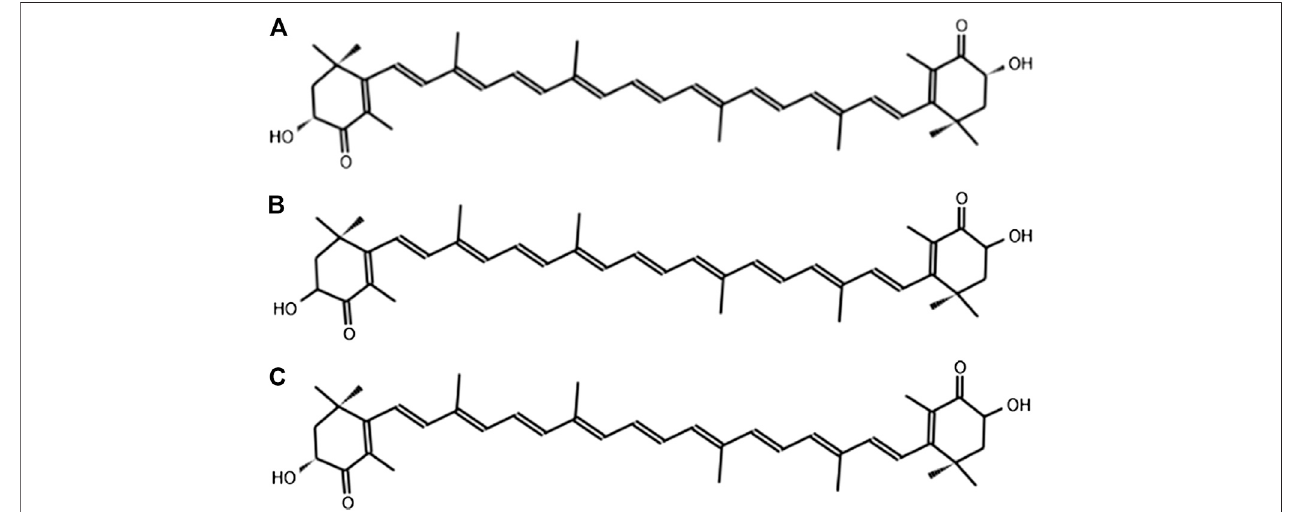
FIGURE 1 | Stereoisomers of the chemical structure of astaxanthin: (A) 3 R,3 ′ R; (B) 3S,3 ′ S; (C) 3R, 3 ′